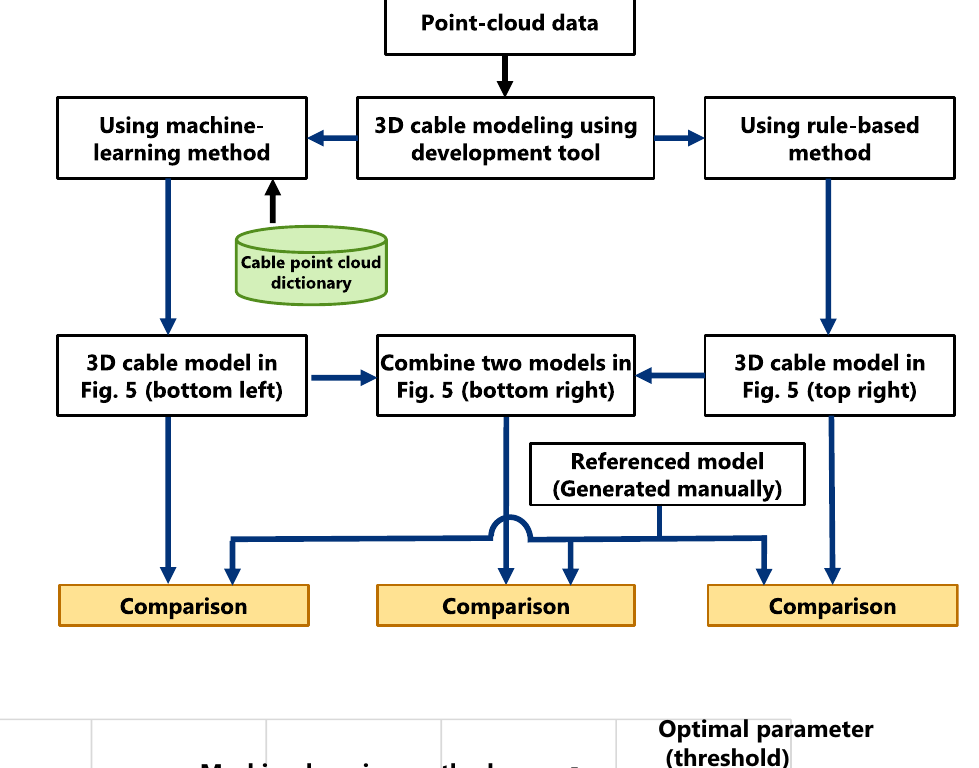
Fig. 6 Evaluation procedure of 3D cable modeling accuracy